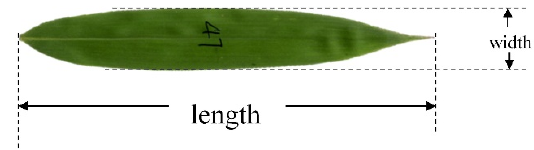
Figure 1. Example of length and width of bamboo leaves.